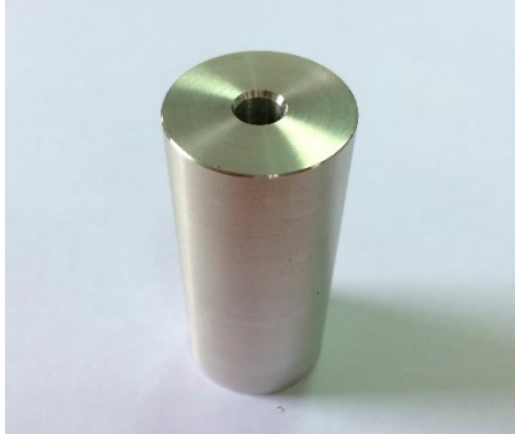
Figure 6. Photograph of the aluminium part used as a case study for the beam hardening correction; the nominal outer diameter is 25 mm, and the nominal inner diameter is 6 mm.